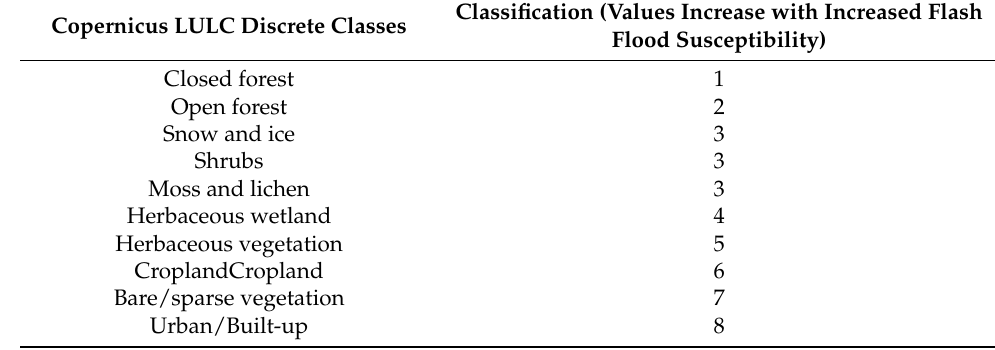
Table A1. Discrete classification of Copernicus Land Use Land Cover (LULC) classes related to increased flash flood